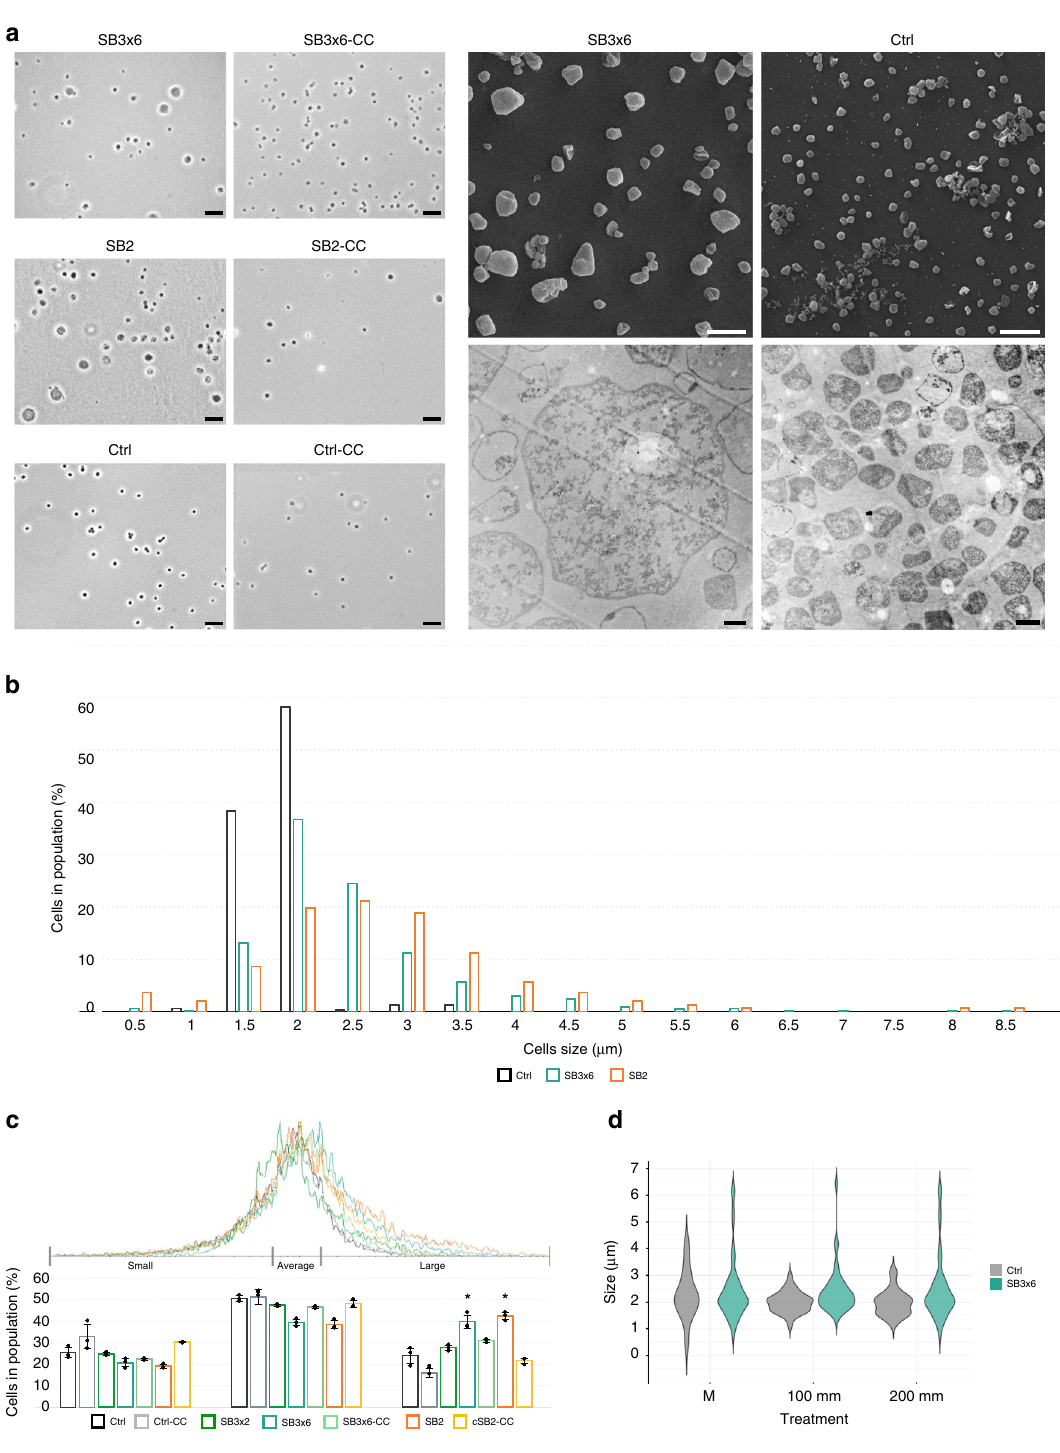
SlaB knockdown affects cell division and chromosome copy numbers . In order to investigate a possible correlation between the large cell phenotype and the measured growth